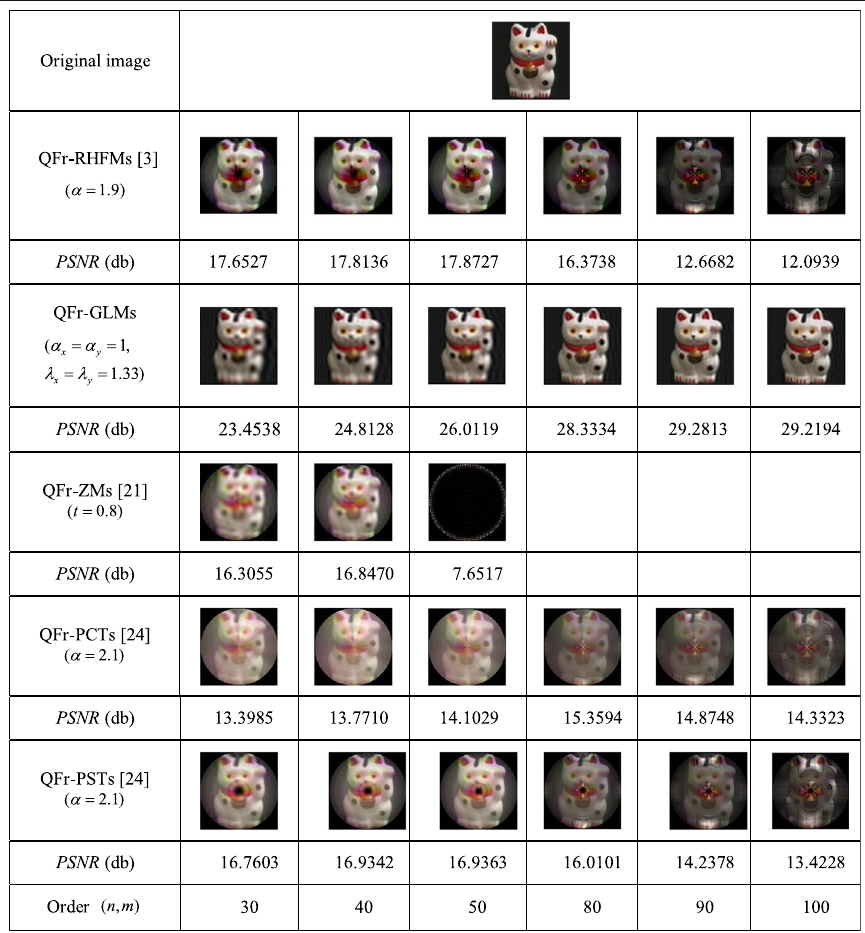
Table 2 Reconstruction performance comparison of different color-image in higher-order